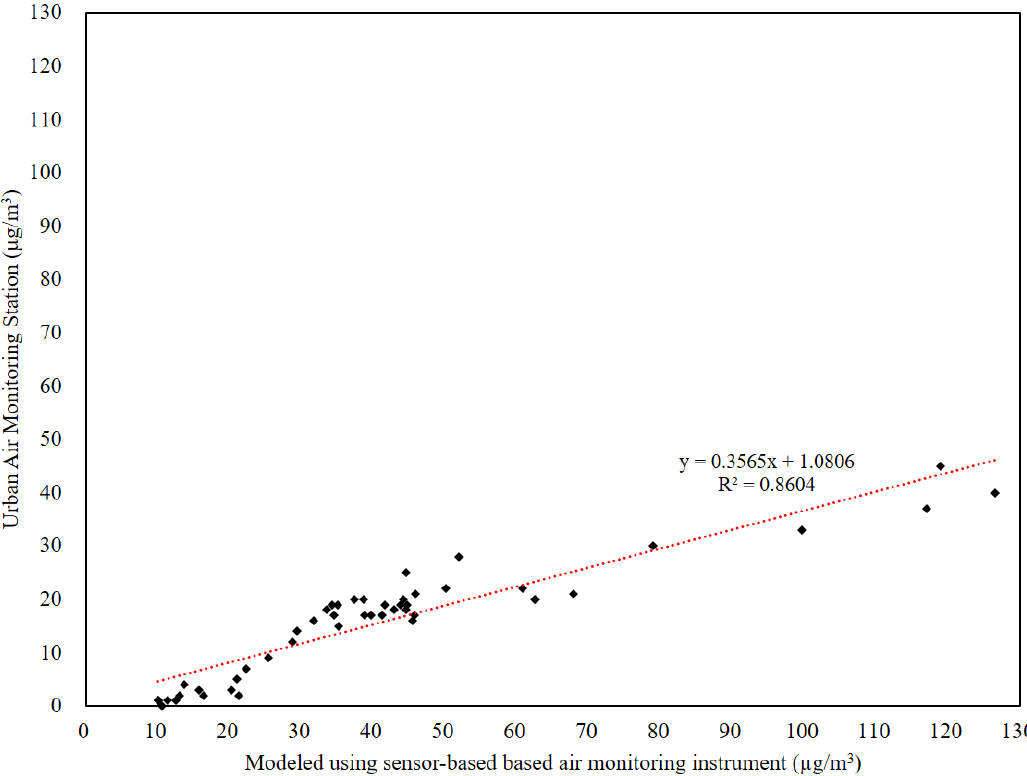
Figure 5. Spatial variation of modeled outdoor PM 2.5 concentration in Guro-gu.